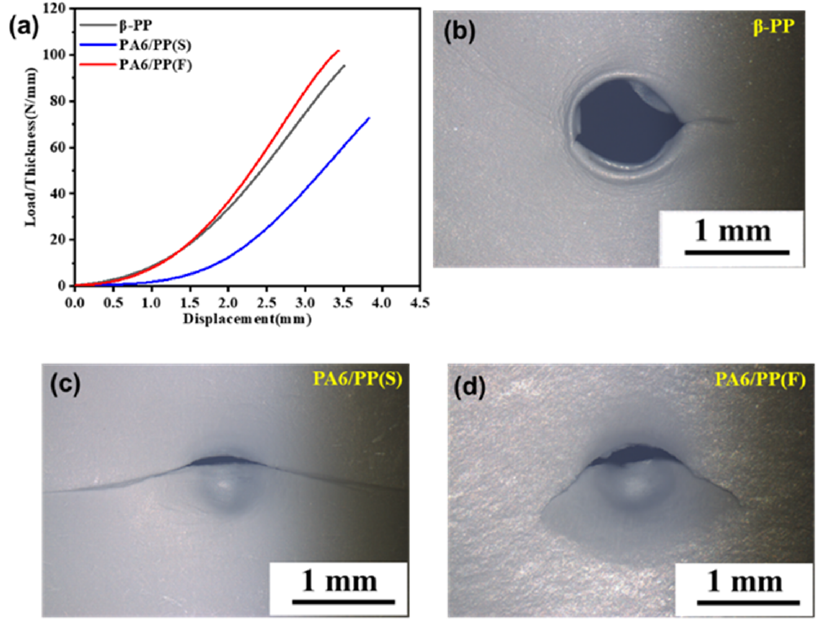
Figure 15. ( a ) The puncture property of β -PP, PA6/PP(S), and PA6/PP(F) microporous membranes; ( b – d ) the optical microscopic photographs of the puncture points after the puncture. The lower tensile strengths of PA6/PP(S) and PA6/PP(F) were presumed to be due to the presence of a weak interface between PA6 and PP. The relatively lower puncture strength of PA6/PP(S) was probably due to the weak PA6–PP interface defect and high porosity of 72.8%. The optical microscope photographs of puncture damage in Figure 15b–d demonstrated that the three membranes had different morphologies of puncture